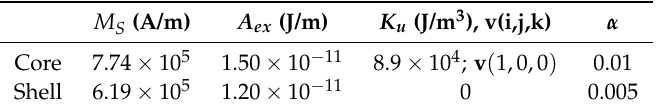
Table 2. Simulation parameters used on mumax3 for the core-shell NP with uniaxial anisotropy. M S is the saturation magnetization, A ex is the exchange energy, K u is the anisotropy constant with its direction vector, v and the damping parameter α